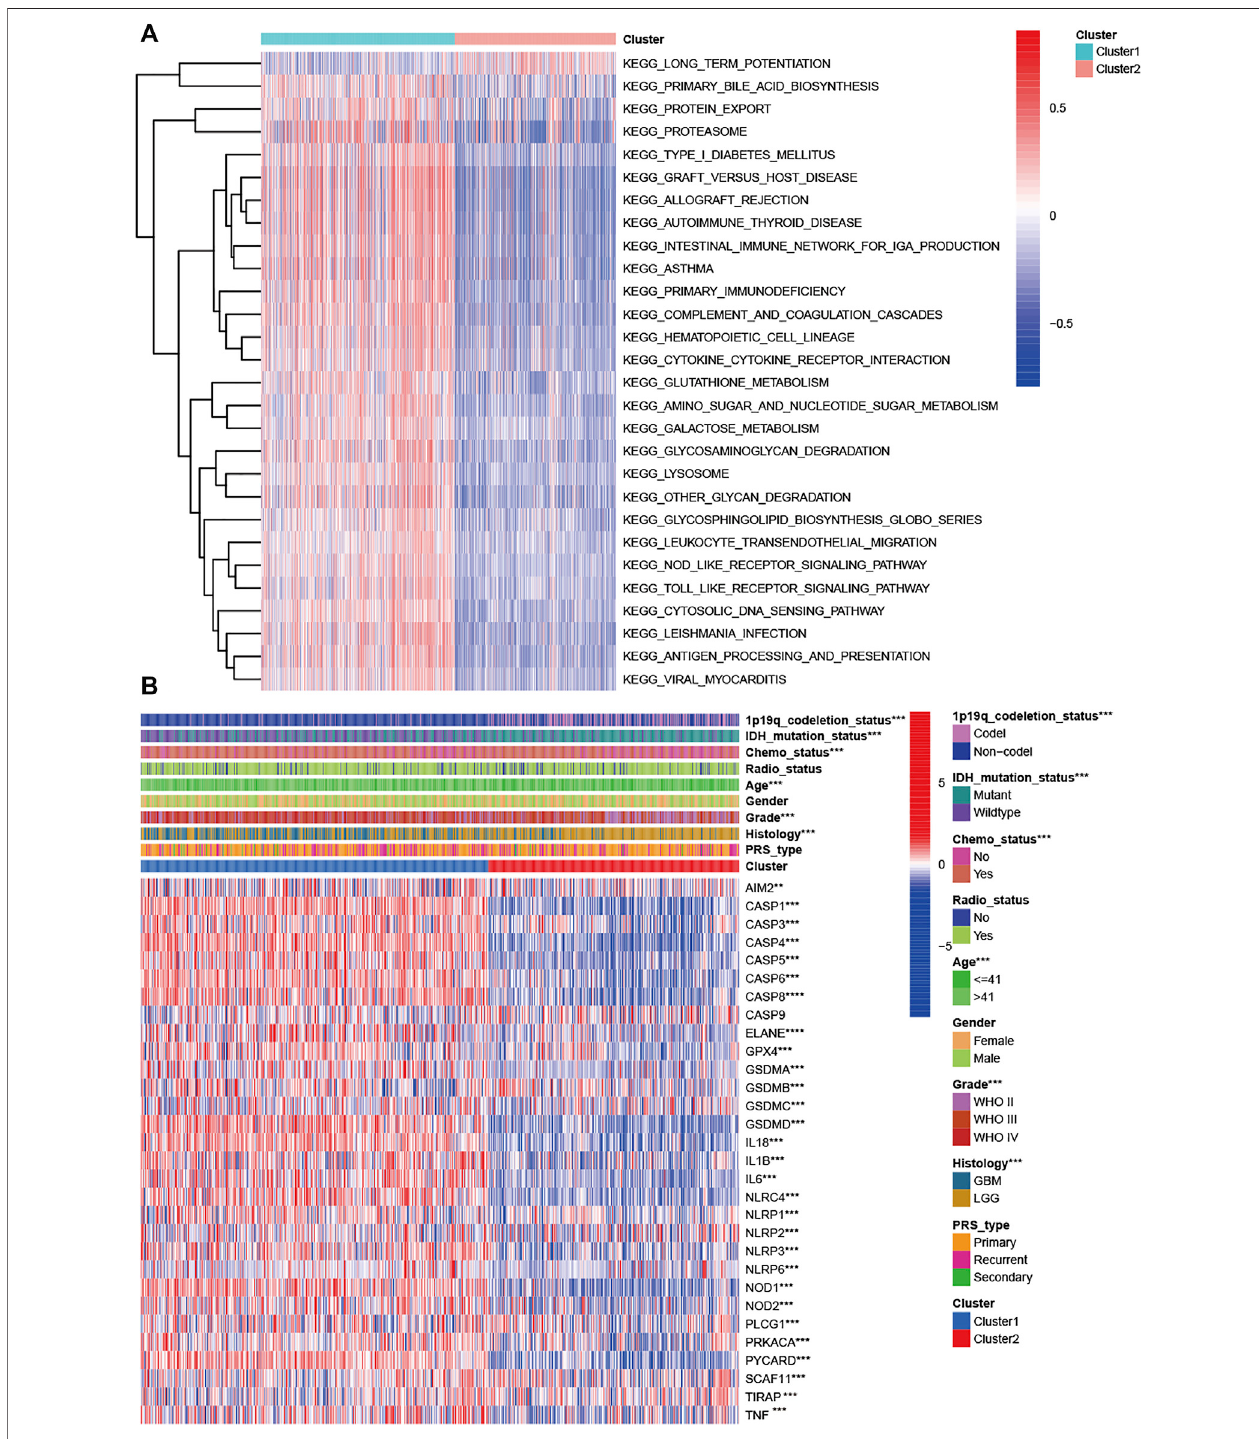
FIGURE 2 | Characteristicsofpatientsincluster1andcluster2inCGGAcohort. (A) Heatmapofgenesetvariationanalysisofthepyroptosis-relatedgenesfromcluster1 andcluster2. (B) Heatmapshowedthecorrelationsbetweentwosubclassesandclinicalcharacteristicsanddifferentiallyexpressedpyroptosis-relatedgenesintheCGGAcohort.